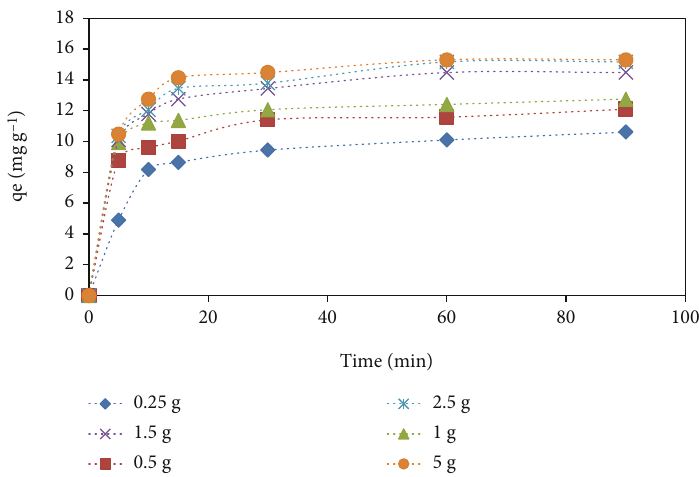
Figure 5: E ff ect of ND concentration on adsorption of carmoisine.